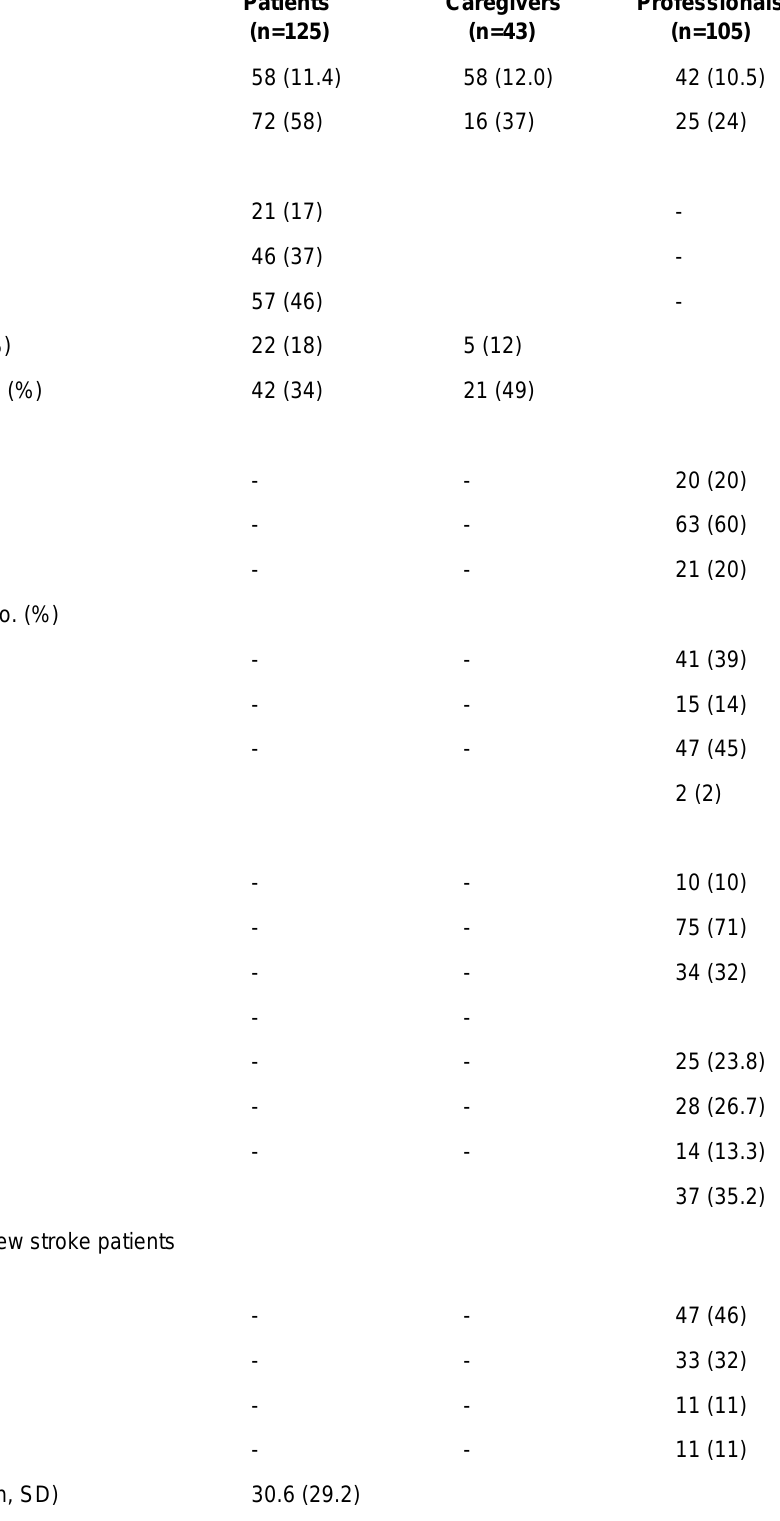
Table 1. Characteristics of Participating Patients, Informal Caregivers and Health Professionals